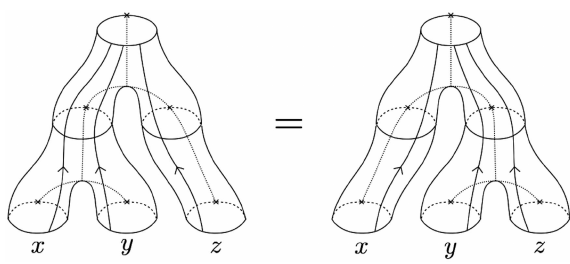
Figure 10 . The multiplication M has the unit i (1) ∈ V 1 .